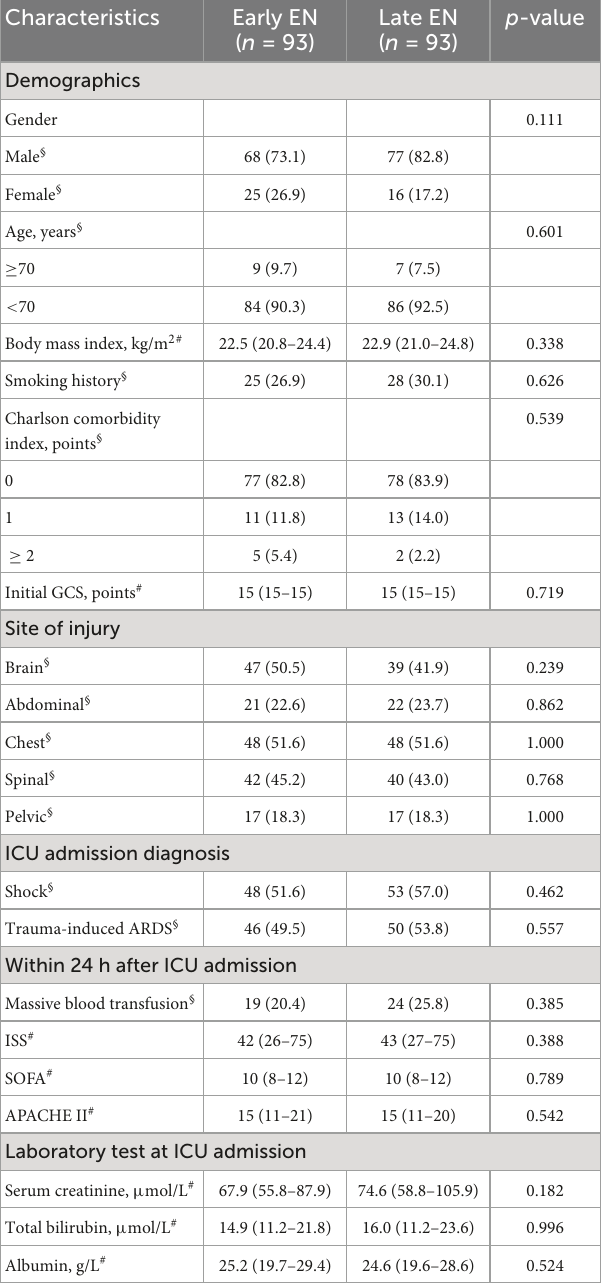
TABLE 3 Comparison of baseline characteristics in early and late enteral nutrition groups after PSM.